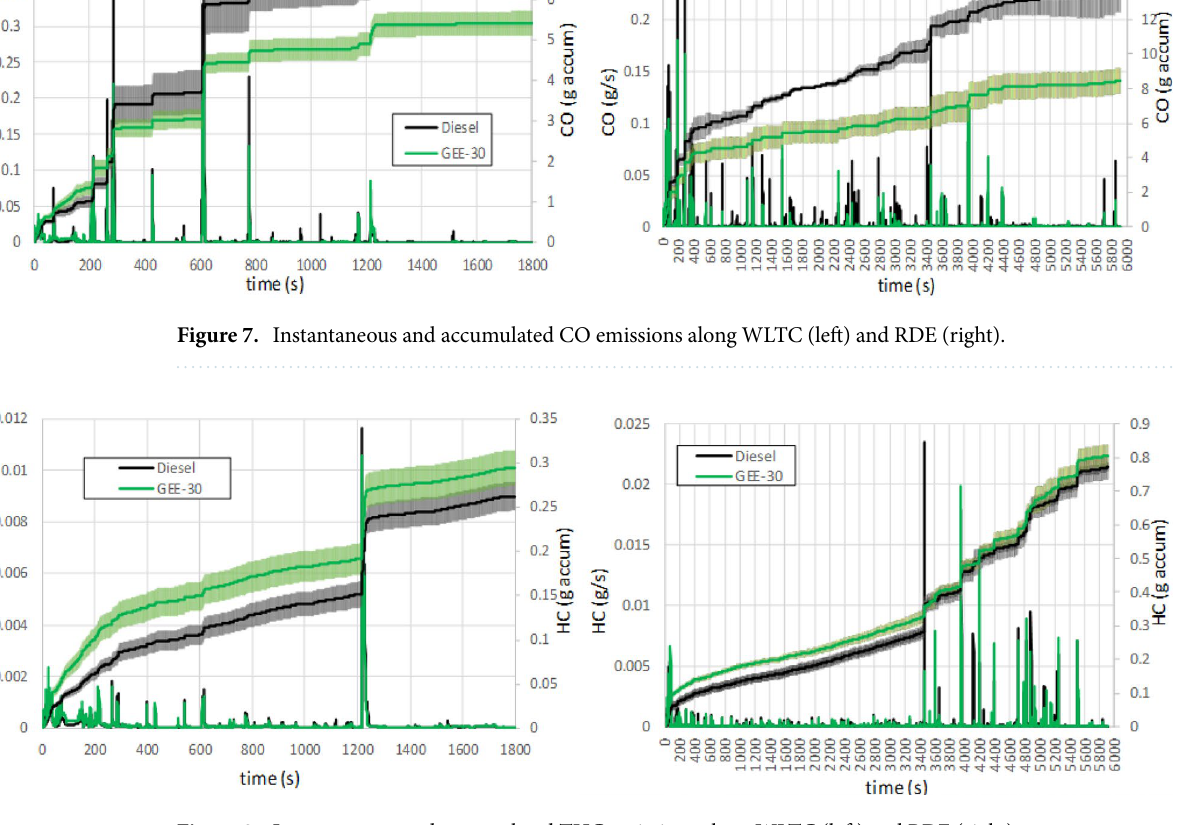
Figure 8. Instantaneous and accumulated THC emissions along WLTC (left) and RDE